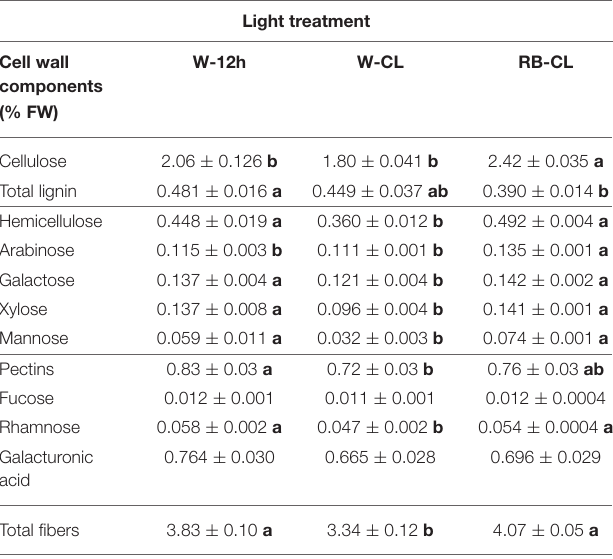
TABLE 5 | Antioxidant content in the leaves of Eruca vesicaria (L.) Cav. grown TABLE 4A | Cell wall component (% fresh weight) content in the leaves of Eruca vesicaria (L.) Cav. grown under three different light treatment conditions. under three different light treatment conditions. Light treatment